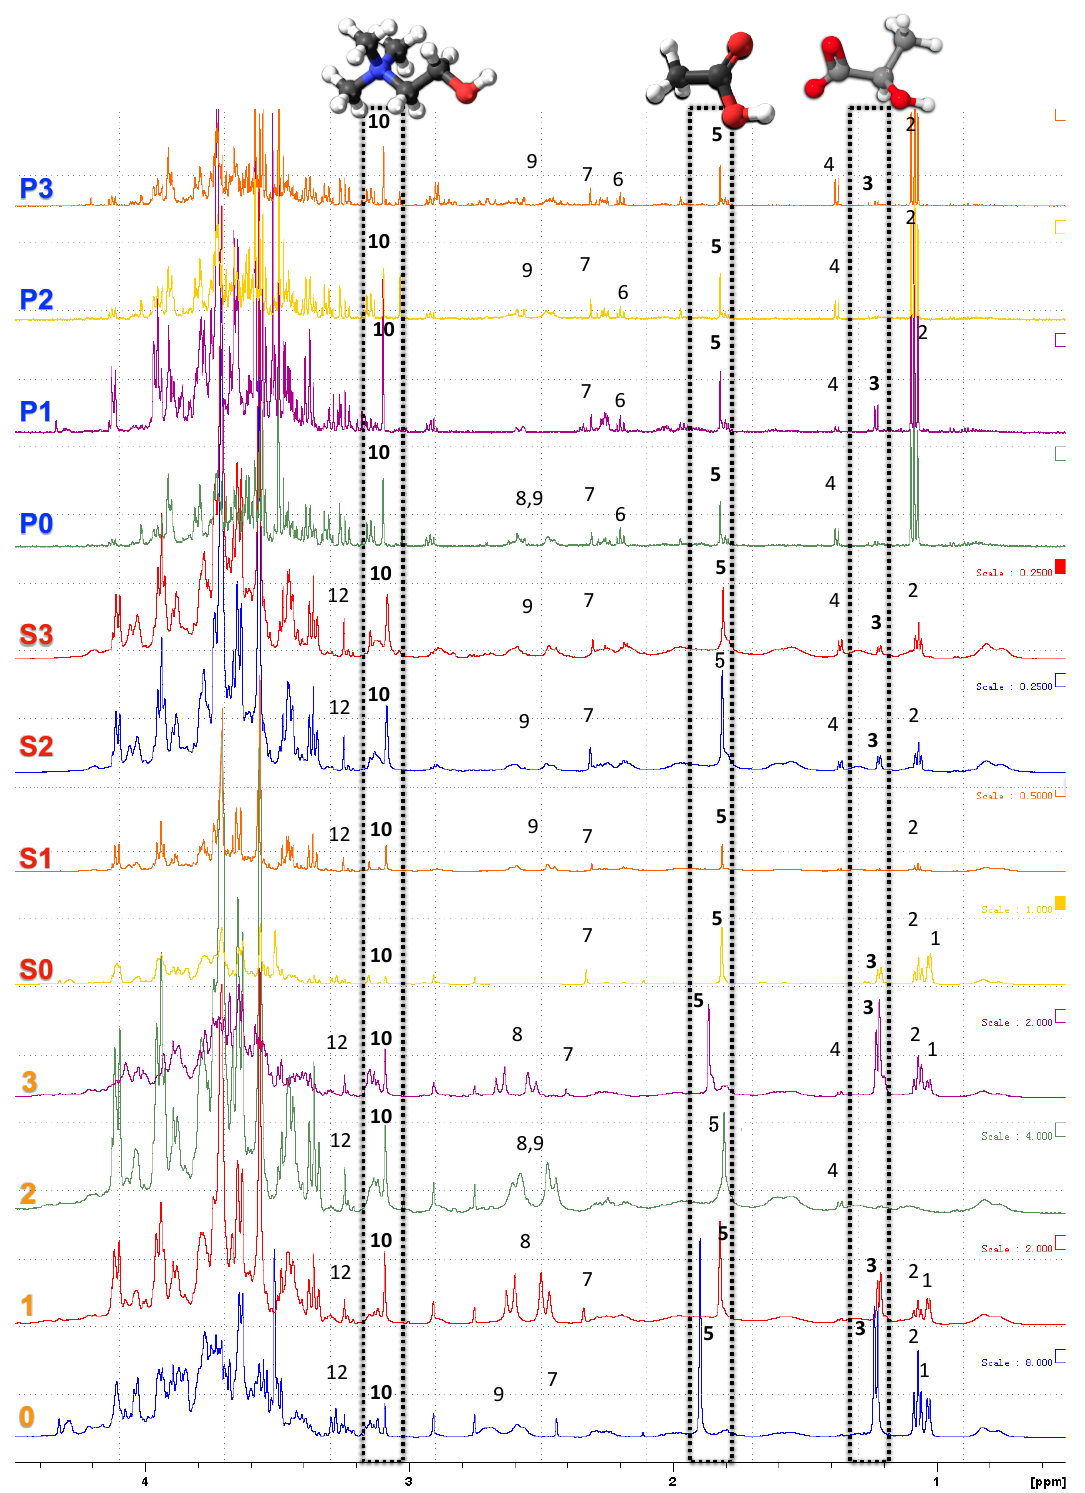
Figure 5. DPFGSE- 1 H-NMR spectra of seed soaking waters/aqueous AQ samples after different treatments. Assigned peaks arise from the presence of 1, isopropanol; 2, ethanol; 3, lactic acid; 4, alanine; 5, acetic acid; 6, glutamine; 7, succinic acid; 8, citric acid; 9, malic acid ; 10, choline; 11, phosphocholine; 12, methanol (Cont’d).